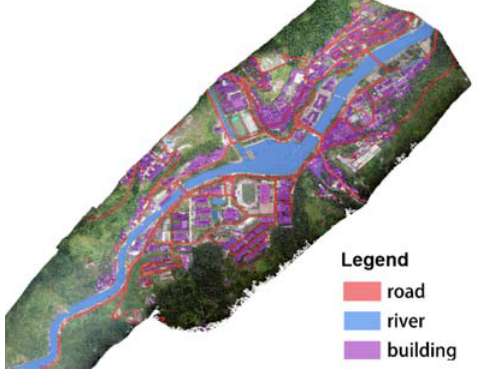
Figure 6. Interpretation Result By AI Technology （